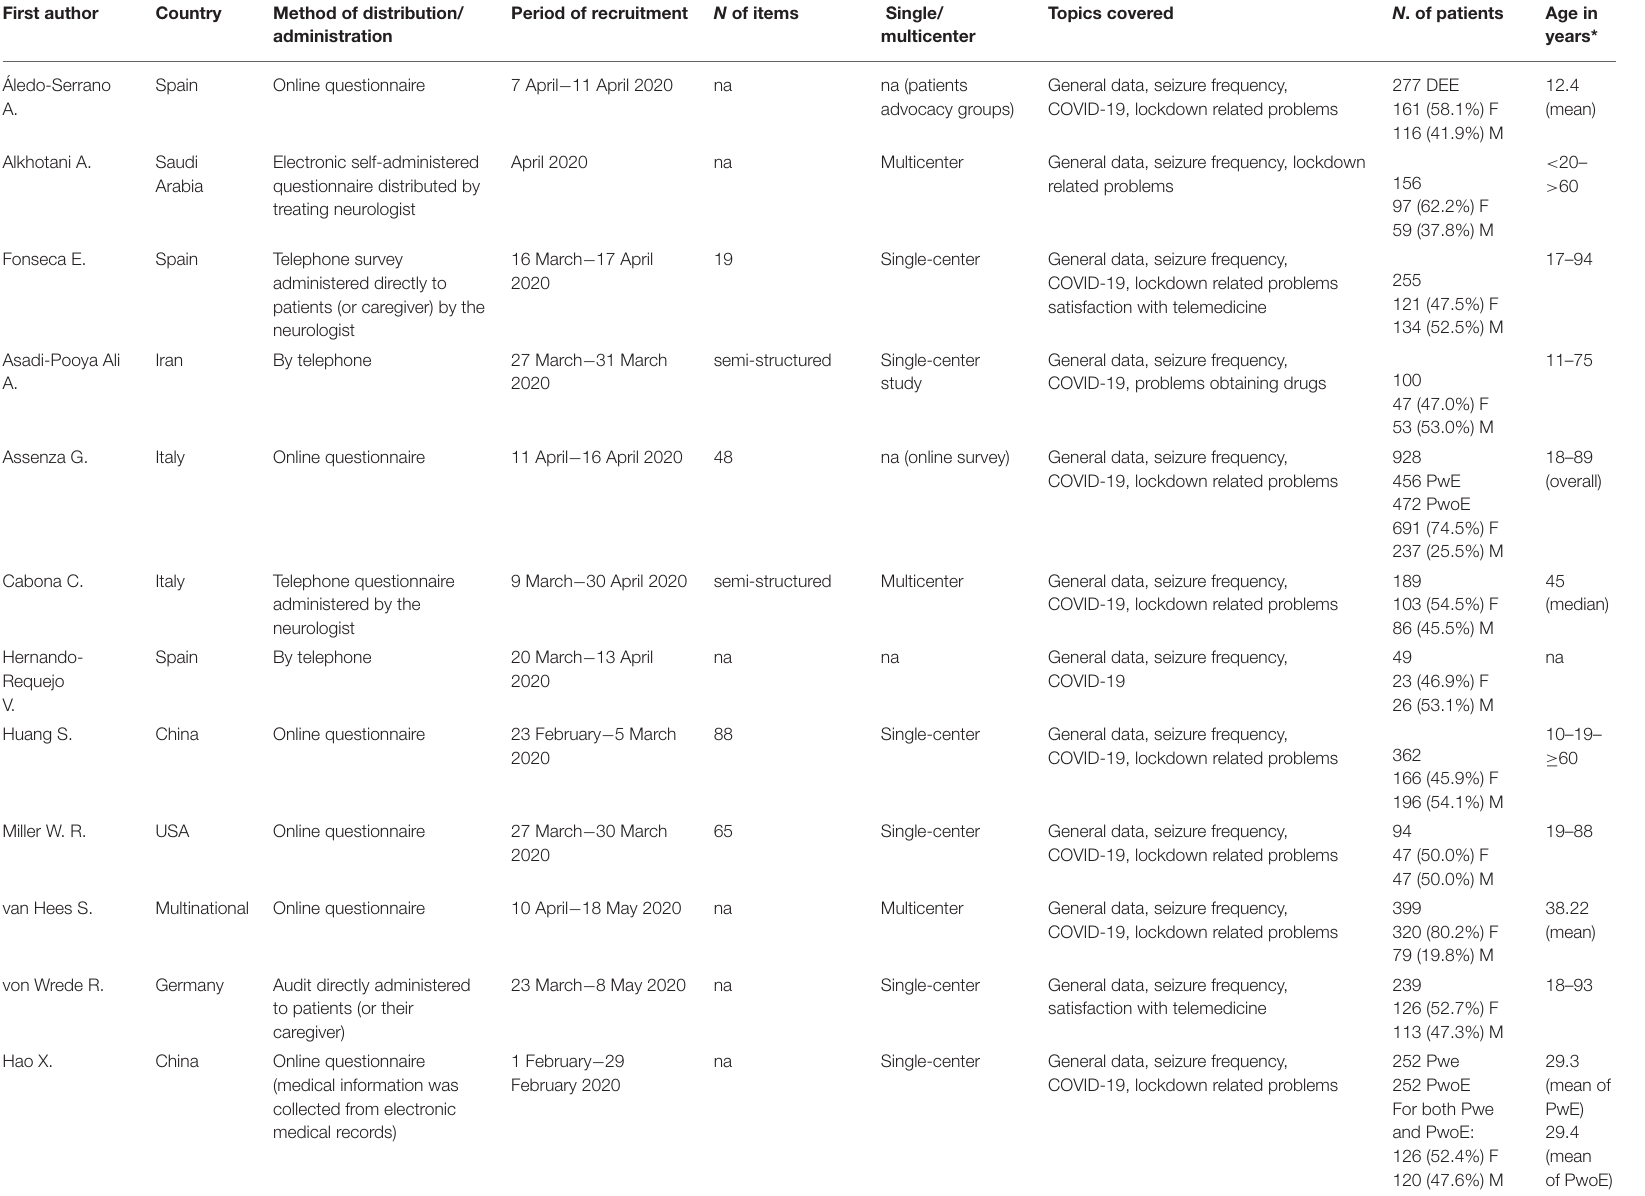
TABLE 1 | Characteristics of the